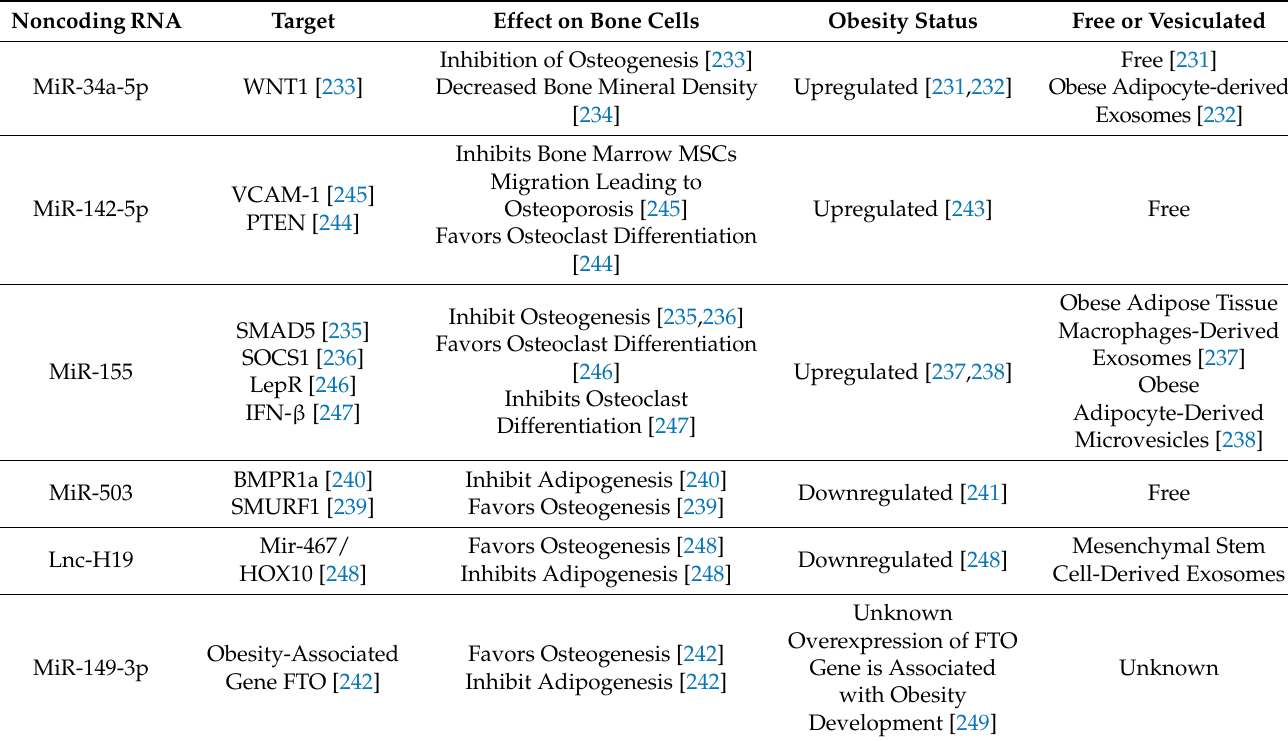
Table 1. Obesity-associated non-coding RNAs and their impacts on bone remodeling. Obese adipose tissue releases non-coding RNAs that promote enhanced formation of osteoclasts and adipocytes while decreasing bone formation and osteoblast differentiation. These non-coding RNAs could be released freely or inside extracellular vesicles, derived mainly by adipocytes and macrophages from obese adipose